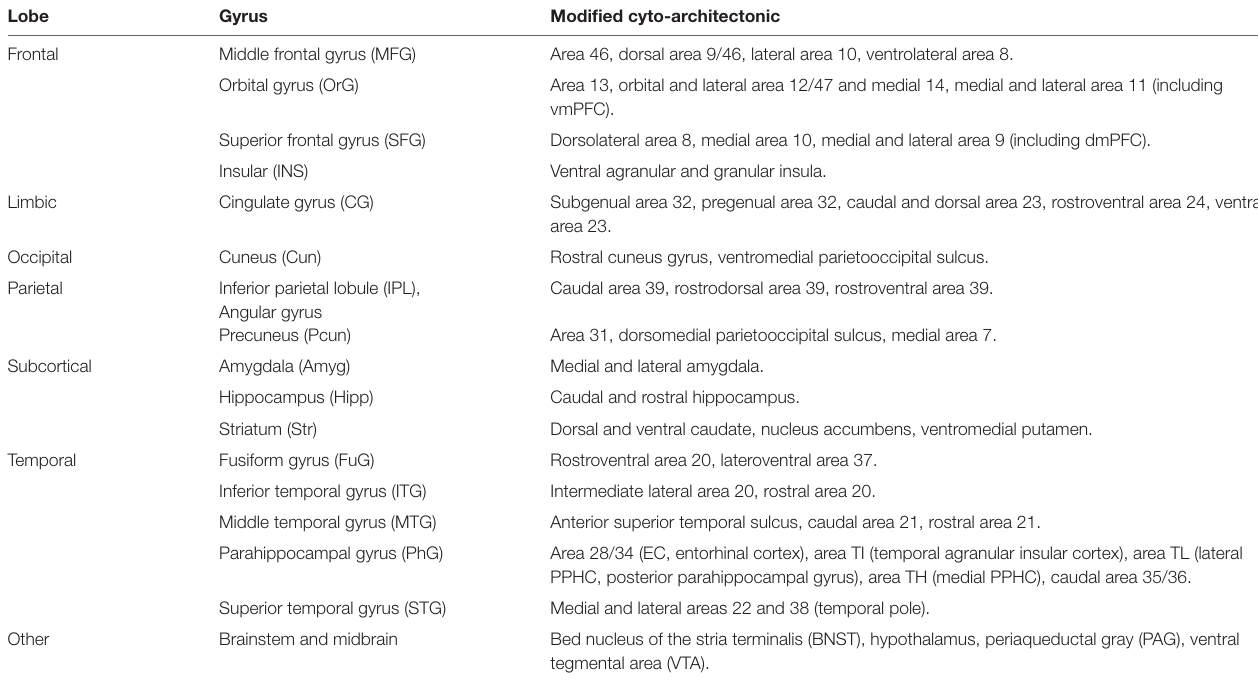
TABLE 1 | Summary table of brain regions that show significant positive FC with the PVT, controlling for the rest of the thalamus (corresponds to positive FC results shown in Figures 2 – 4